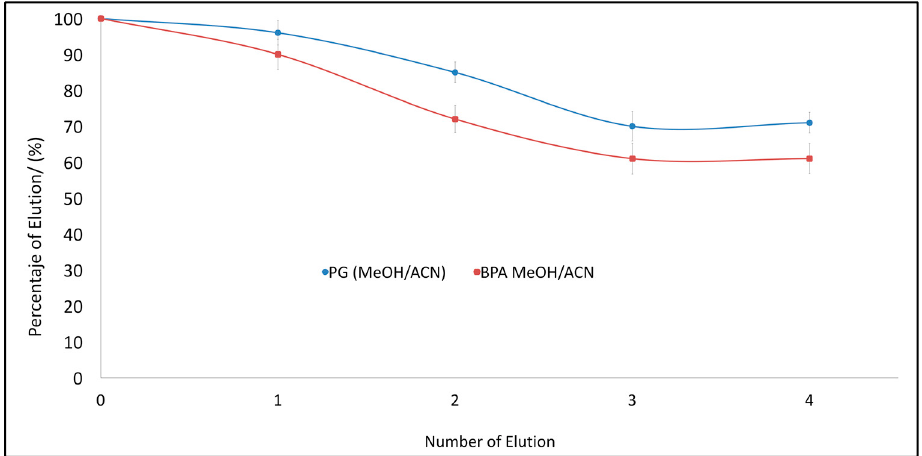
Figure 8. Elution capacity of PG and BPA from consecutive loading and unloading cycles in MIP 2. Error bars represent ±1 standard deviation. Experiments were performed in triplicate.